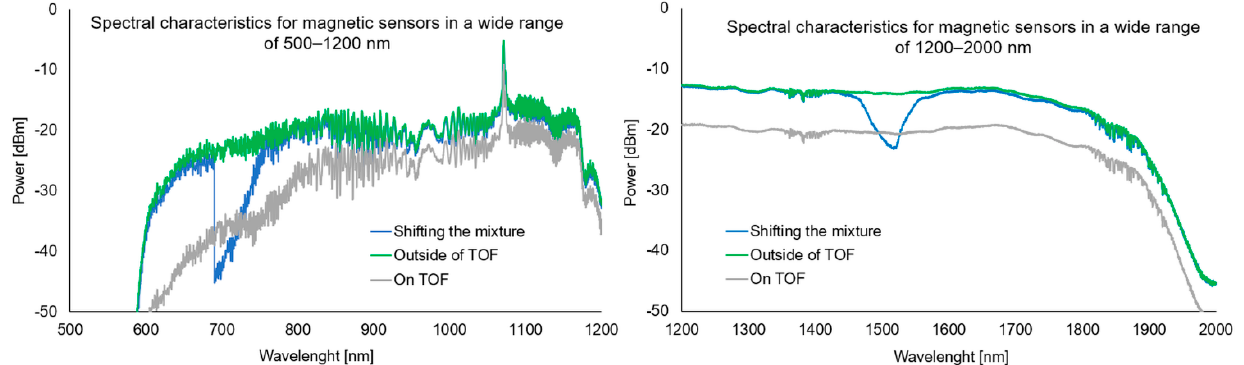
Figure 10. Spectral characteristics for magnetic sensors in a wide range of 500–1200 nm and 200–1200 nm with a mixture outside the taper region (green line), on the taper region (grey line), and visualization of the sliding mixture along the taper (blue line).